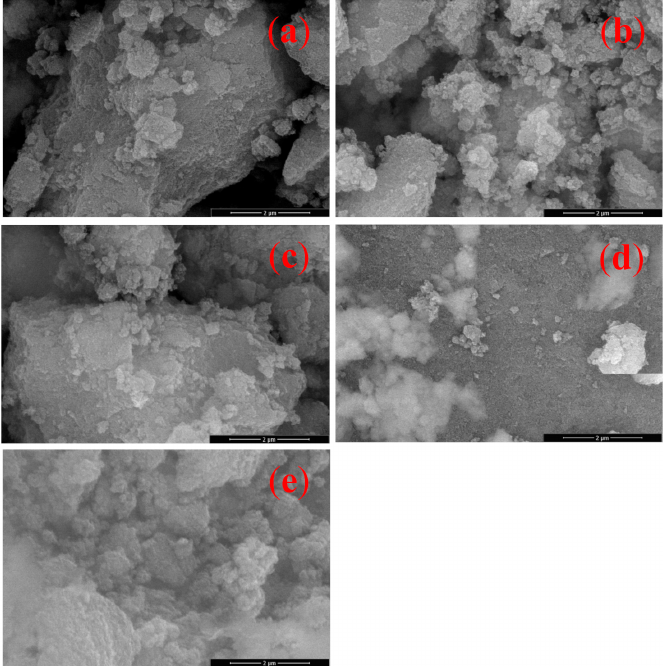
Figure 3. FESEM micrographs of HAP modified with co-doped Ag/V in powder phase: ( a ) 0.0 Ag/V-HAP, ( b ) 0.2 Ag/V-HAP, ( c ) 0.4 Ag/V-HAP, ( d ) 0.6 Ag/V-HAP, ( e ) 0.8